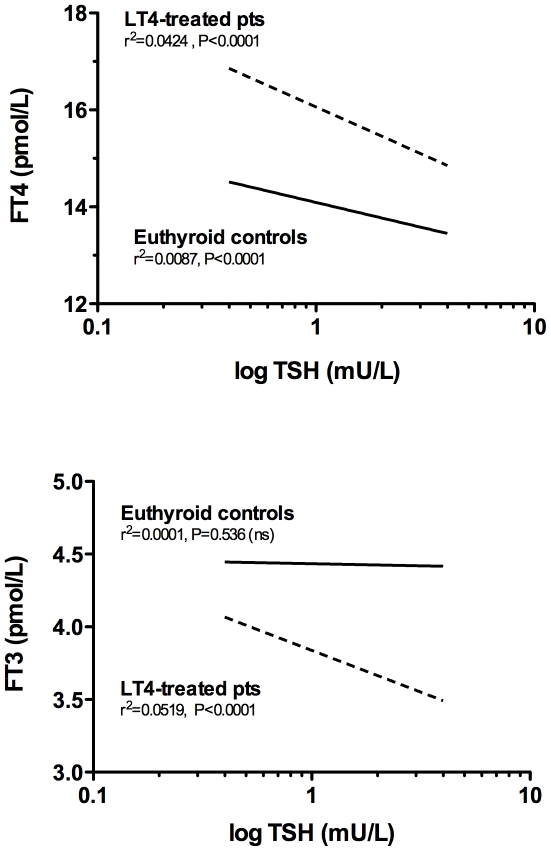
Correlation between TSH and free thyroid hormones in euthyroid controls and in athyreotic patients.The correlation between TSH serum levels (log values) and FT3 and FT4 serum levels in 3,875 euthyroid controls (solid lines) and 1,811 athyreotic patients under levothyroxine monotherapy (dotted lines). The linear regression equations between FT4 and log TSH levels in the euthyroid controls and the levothyroxine (L-T4)-treated patients were y = 14.0−1.1x (95%: slope −1.4 to −0.74) and y = 16.1−2.01x (95% CI: slope −2.48 to −1.53), respectively. The same curve fitting analysis was used between FT3 and log-TSH levels and resulted in the following: y = 4.4−0.029x (95% CI: slope −0.128 to 0.063) for euthyroid controls and y = 3.84−0.575x (95% CI: slope −0.697 to −0.453) for L-T4-treated patients. R square and P values are reported in the graph.